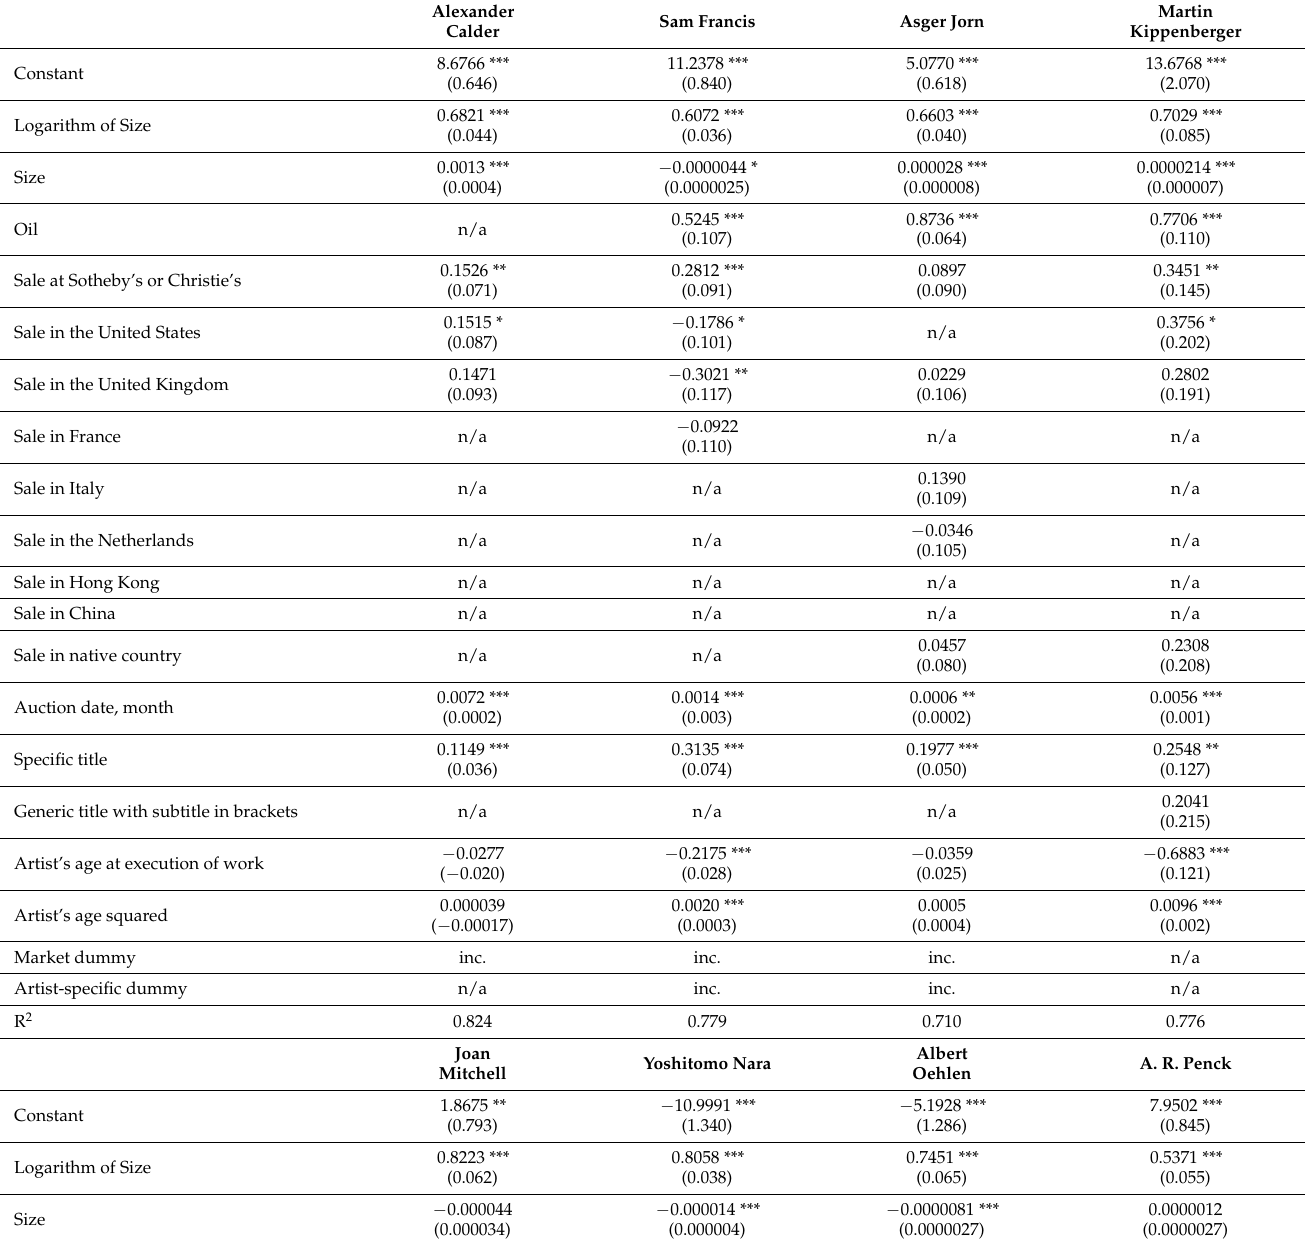
Table A4. Results from Regression